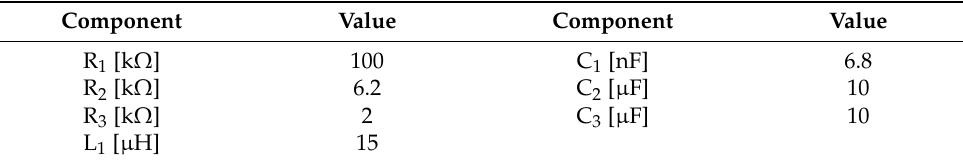
Table 3. Passive components in the receiver system—block